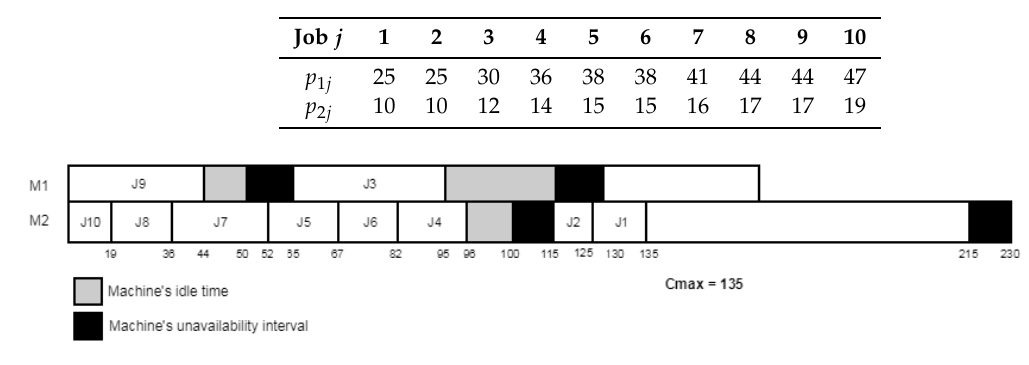
Table 2. Input data for 10 jobs and two machines.